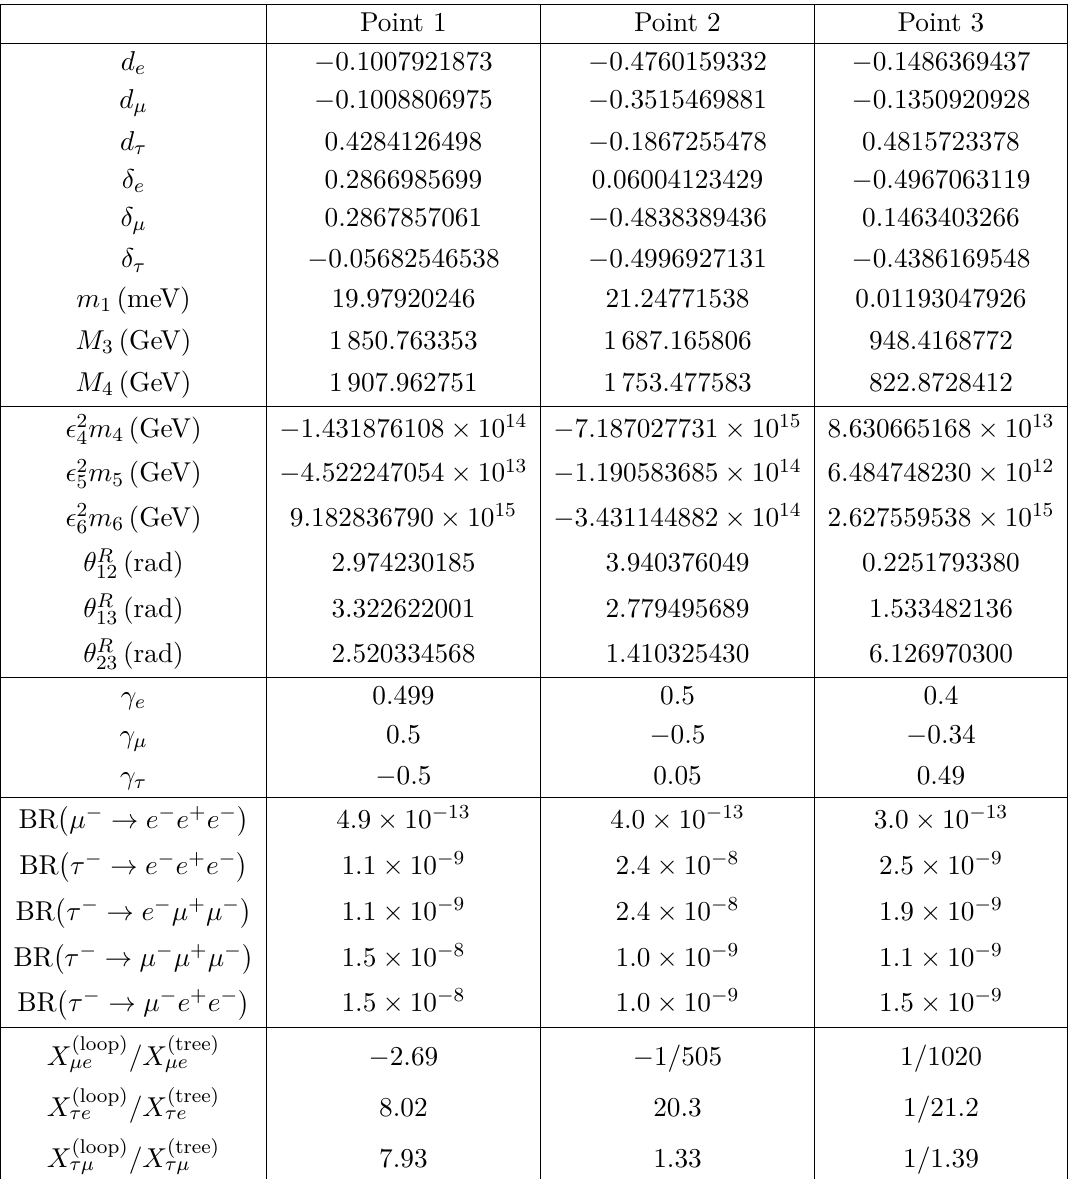
Table 2 . Three benchmark